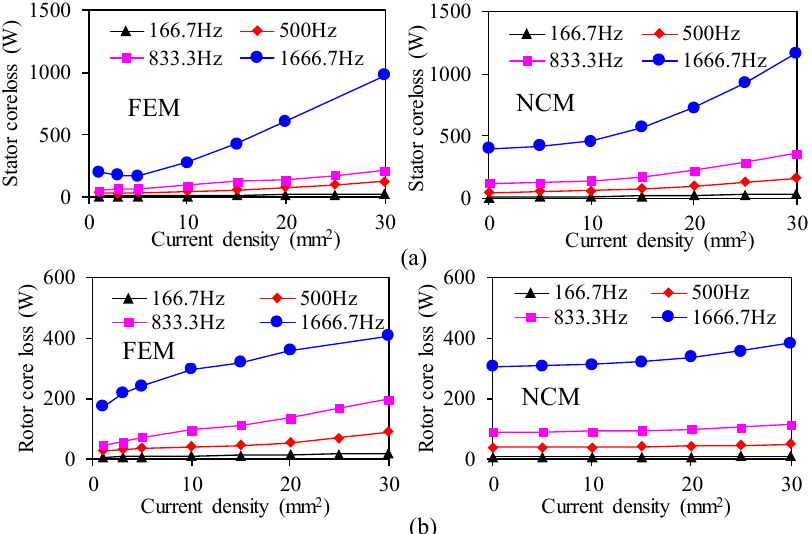
Figure 8. Comparison of core losses by FEM and NCM. ( a ) Stator core loss and ( b ) rotor core loss.